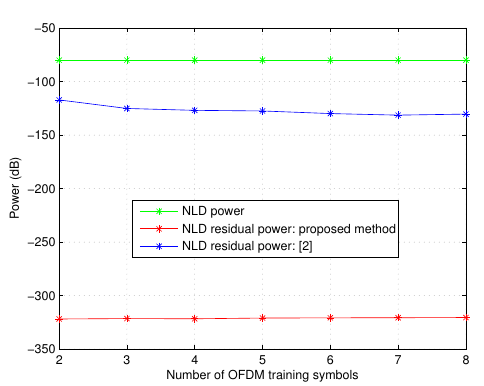
for various values x